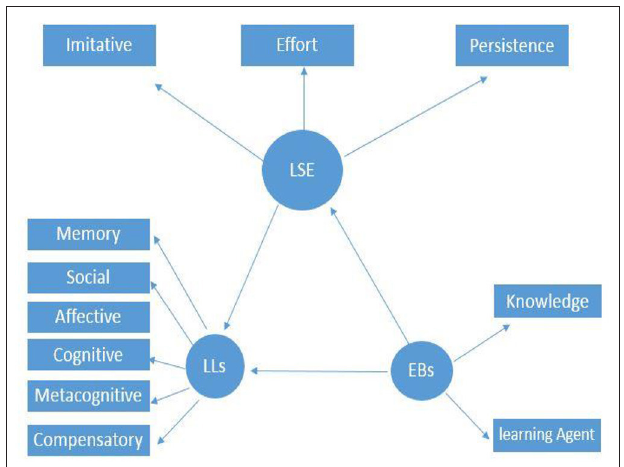
FIGURE 1 | The hypothesized SEM model and the causal paths among the variables.